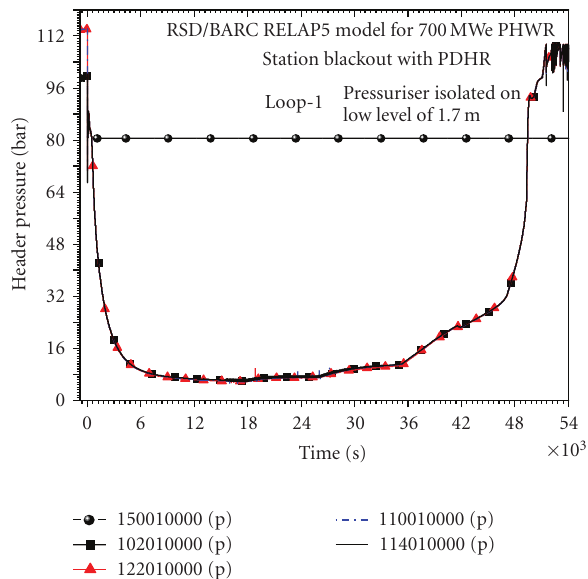
Figure 8: PHT system pressure case-6 minutes.